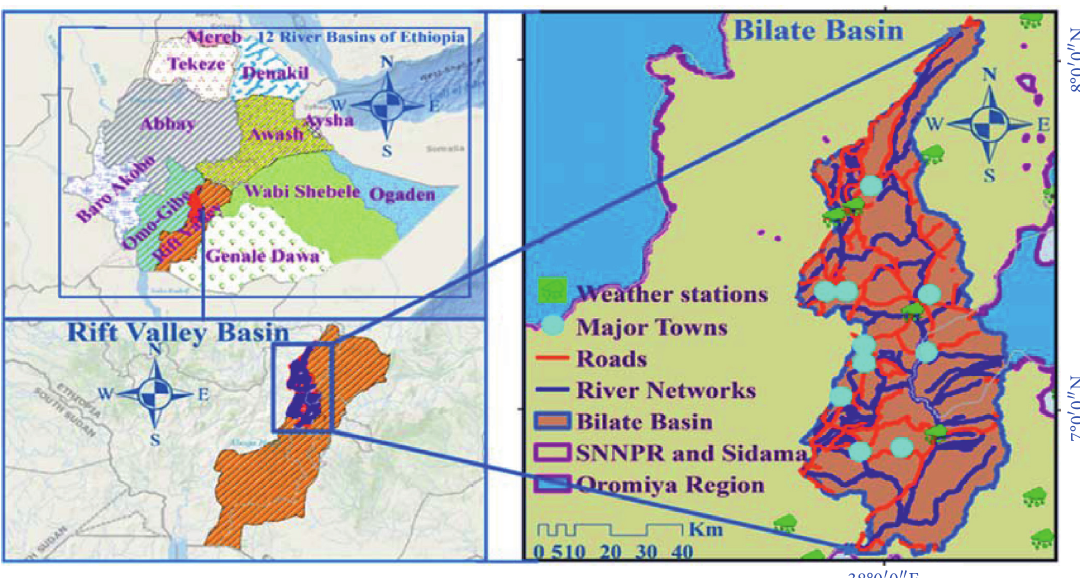
Figure 1: Map of the study